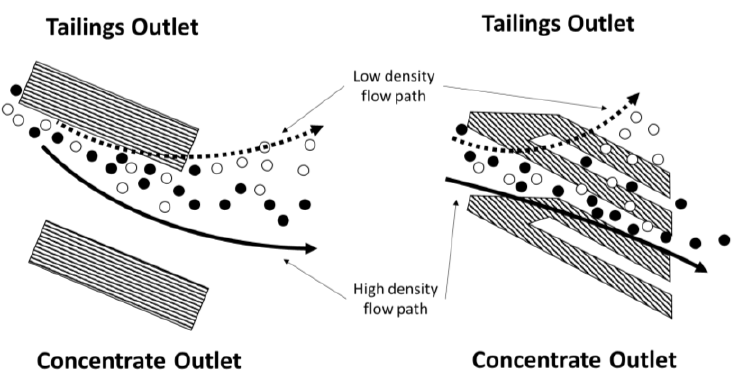
Figure 6. Plan view of scraping blades. Conventional scraping blade system is shown on the left and the novel, low profile scraping blades on the right.